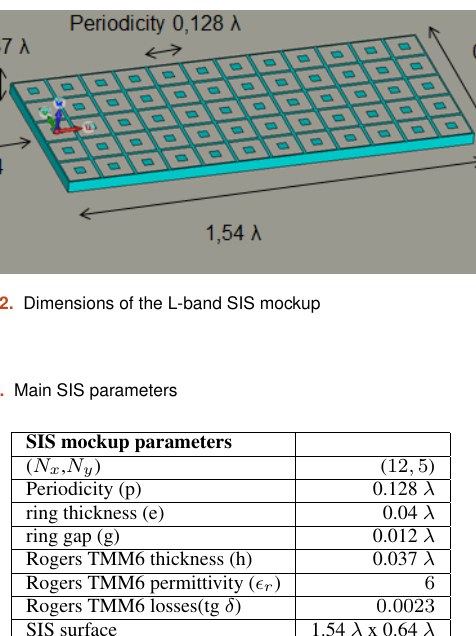
up of N x = 12 and N y = 5 metal rings. Lattice periodicity is p = 0.128 λ . The metasurface’s metal cells are printed on a Rogers TMM6 substrate of thickness h = 0.037 λ ( (cid:15) r = 6, tg δ = 0.0023). The in-plane thickness of the rings is e = 0.04 λ , and the gap between two rings is g = 0.012 λ . The total length of the SIS launcher is equal to Lx = 1.535 λ and its width is equal to Ly = 0.64 λ .